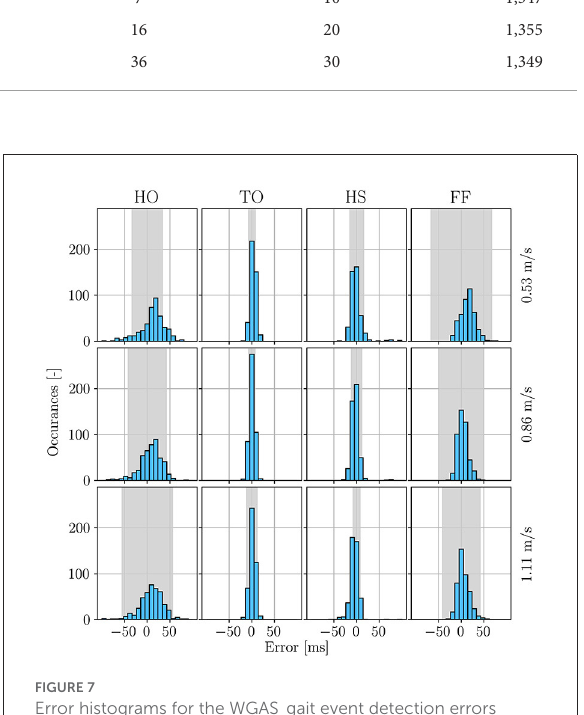
FIGURE7 Error histograms for the WGAS gait event detection errors grouped by the set treadmill speed and event type. The histograms are plotted with a bin size of 10ms, and for comparison, the uncertainty bounds of the manual labeled events are shown in